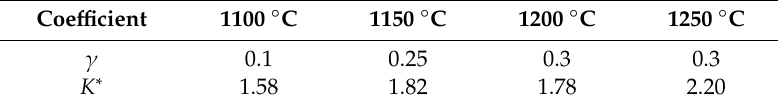
Table 3. The optimized values of the fracture model coe ffi